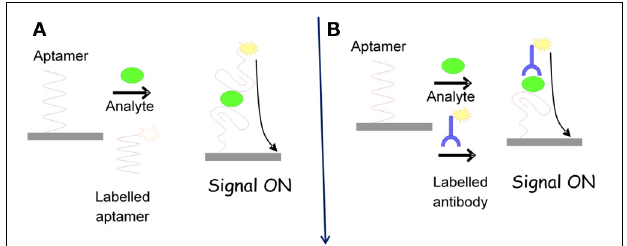
FIGURE 2 | Signal ON formats for aptasensing.